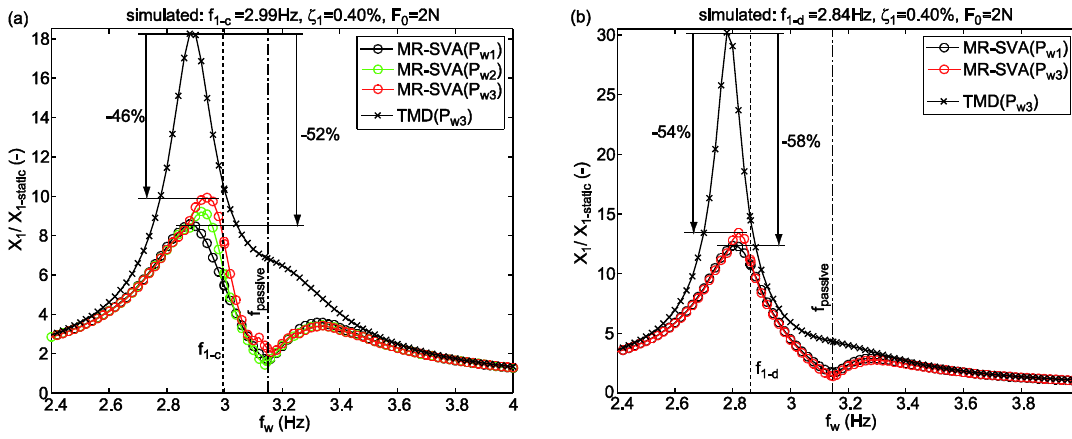
Figure 8. Simulated vibration reductions of heavier primary structures with ( a ) c1 f and ( b ) d1 f .